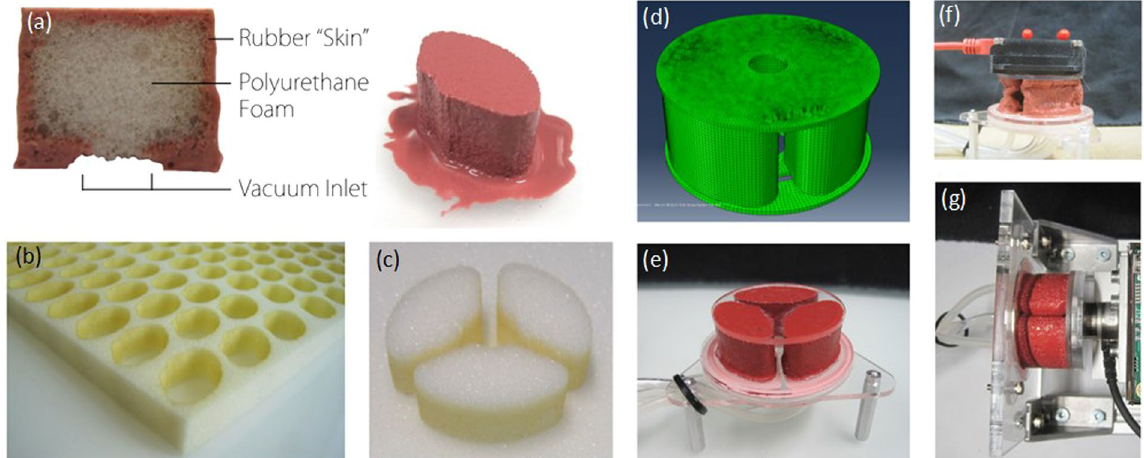
Figure 2. (a – c) Fabrication of the V-SPA module using a cutout polyurethane foam chamber which is painted with molten Elastosil rubber that acts as a restoring “skin” for the foam. Three such chambers are aligned as shown in ( c ) to form the 3-DOF module. (d) FE model for a single module containing the three chambers covered with top and bottom end-plates. (e) Fully assembled V-SPA module with top and bottom fiberglass end-plates. (f) A module undergoing free displacement testing, using an inertial measurement unit mounted on the top plate to measure displacements. (g) A module undergoing blocked force testing, using a load cell attached to the plate on the right